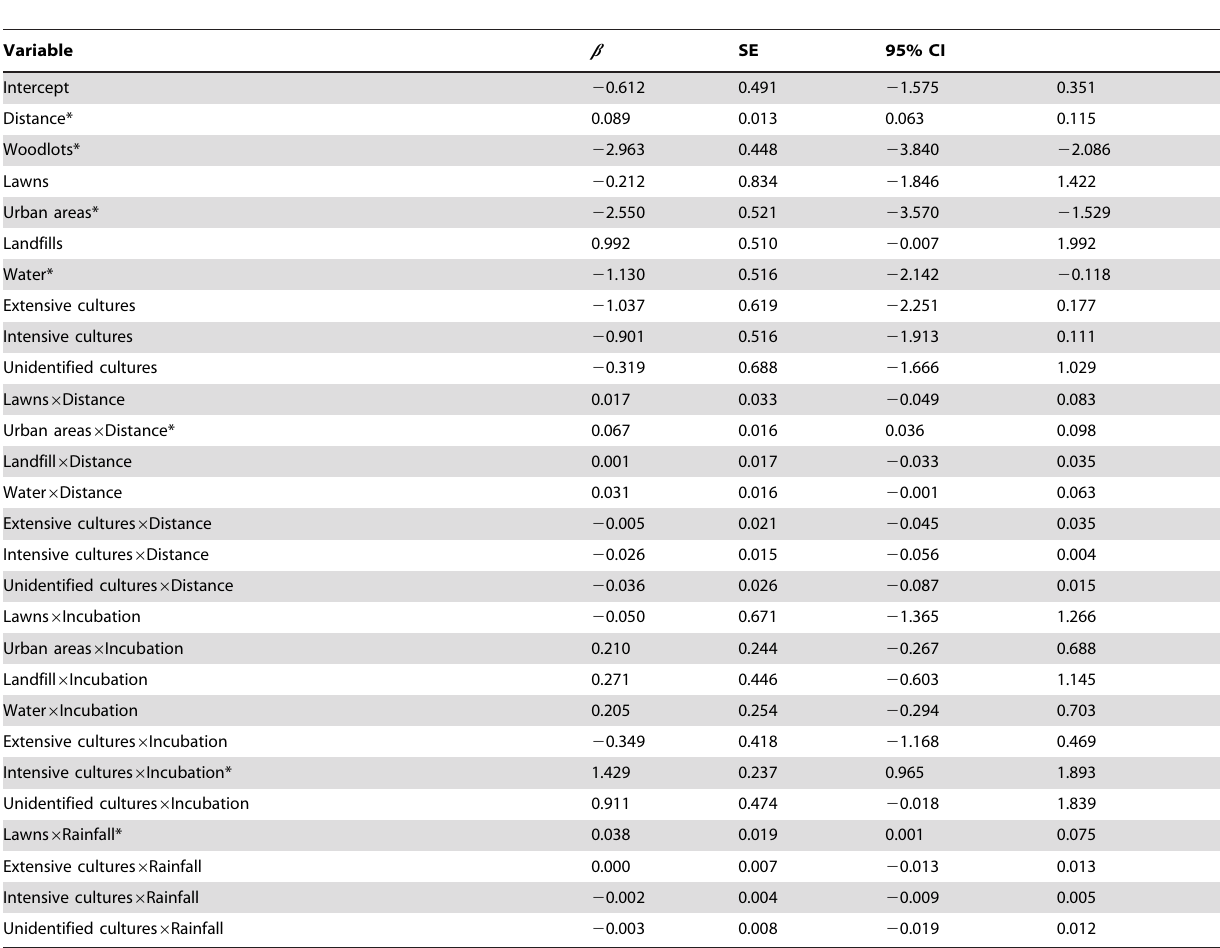
Table 3. Mixed-effects averaged logit resource selection functions quantifying the probability that a breeding Ring-billed gull forage in a